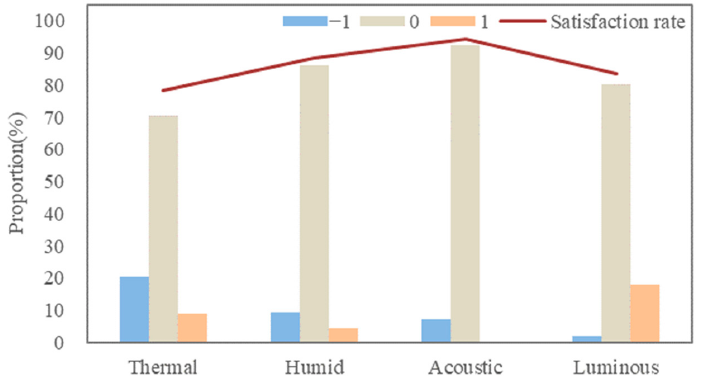
Figure 3. Environmental satisfaction rate and environmental expectation vote distribution.